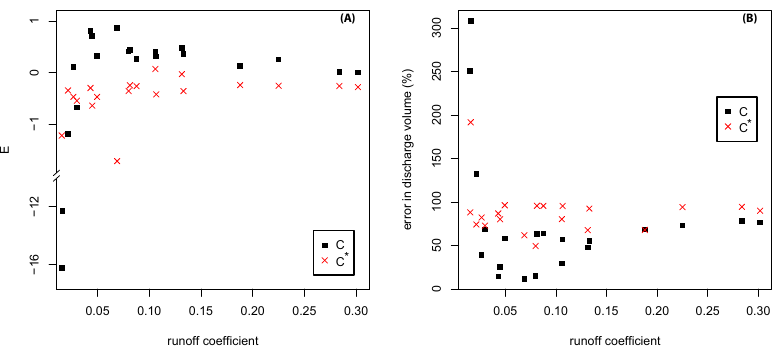
Fig. 10. Performance of the calibrated closure relation C and C ∗ versus the runoff coefficient of events. (A) Nash–Sutcliffe index; (B) percent error in discharge